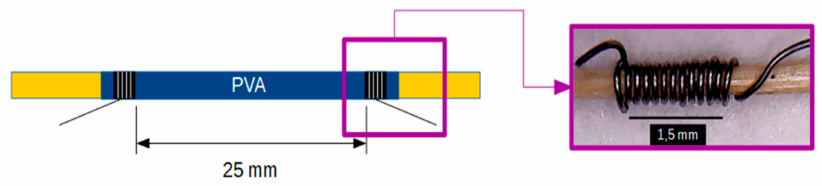
Figure 2. Diagram of sensor yarn with a focus on the wrapped